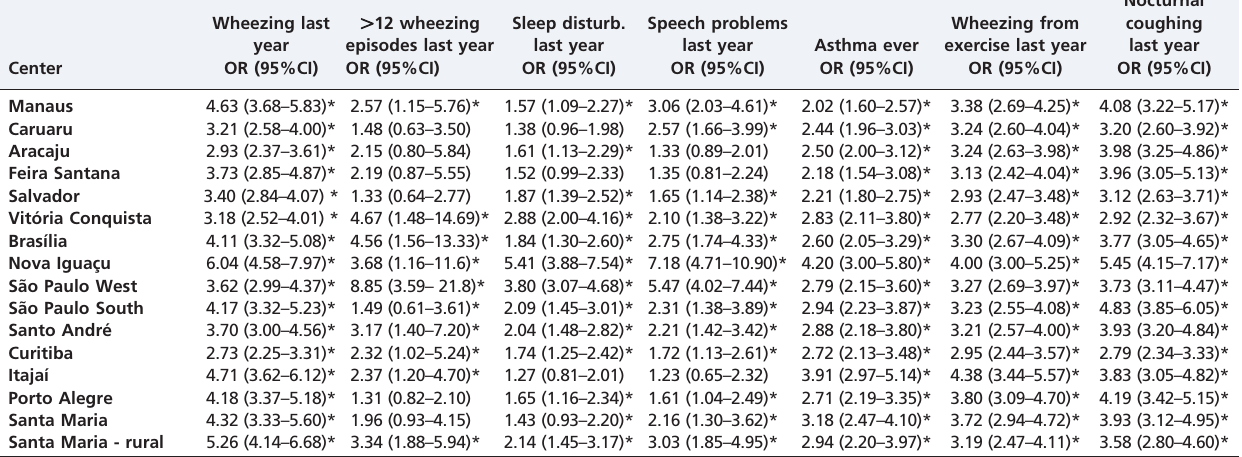
Table 3 - Odds ratio (OR) and 95% confidence interval (95% CI) for wheezing-related symptoms in Brazilian adolescents from ISAAC Phase Three centers with current